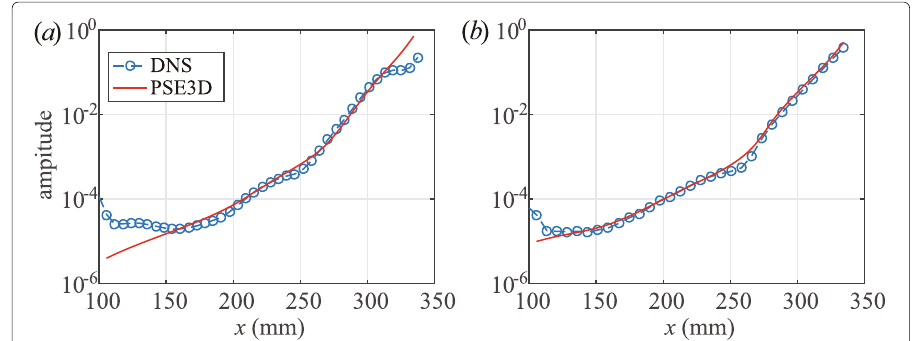
Fig. 8 Comparison of amplitude evolutions from DNS and PSE3D results for ( a ) the varicose mode of 135 kHz and ( b ) the sinuous mode of 95 kHz. The amplitude is defined as the maximum of the temperature